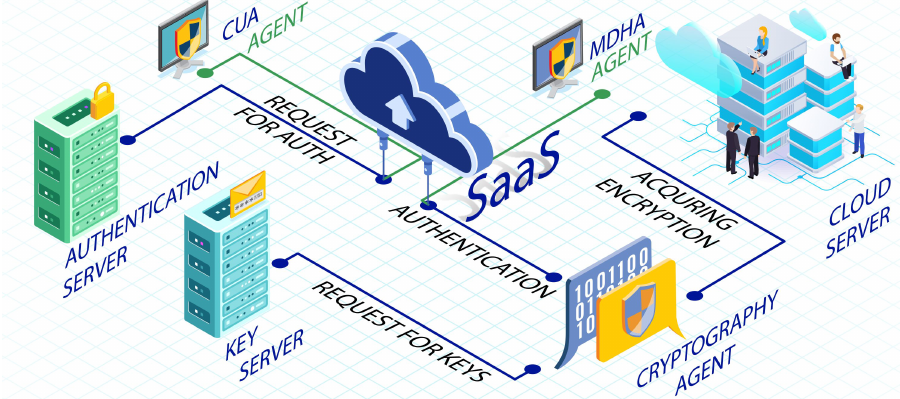
Figure 3. An architecture proposed in [88] for user authentication based on agents and SAAS